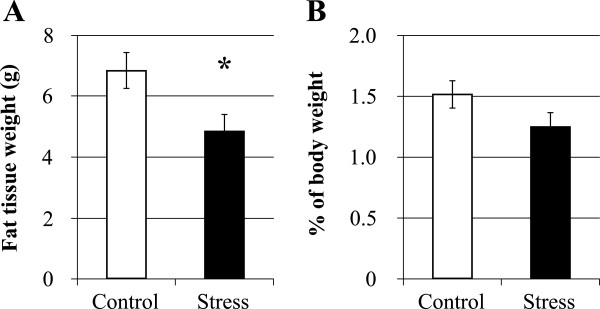
The effects of chronic social defeat stress on the epididymal fat tissue. (A) The epididymal fat weight. (B) The percentage of fat weight to body weight at the end of the experiment. *P < 0.05 (Student’s t-test). Data represent the mean ± S.E.M. (Control, n = 8, Stress, n = 7).